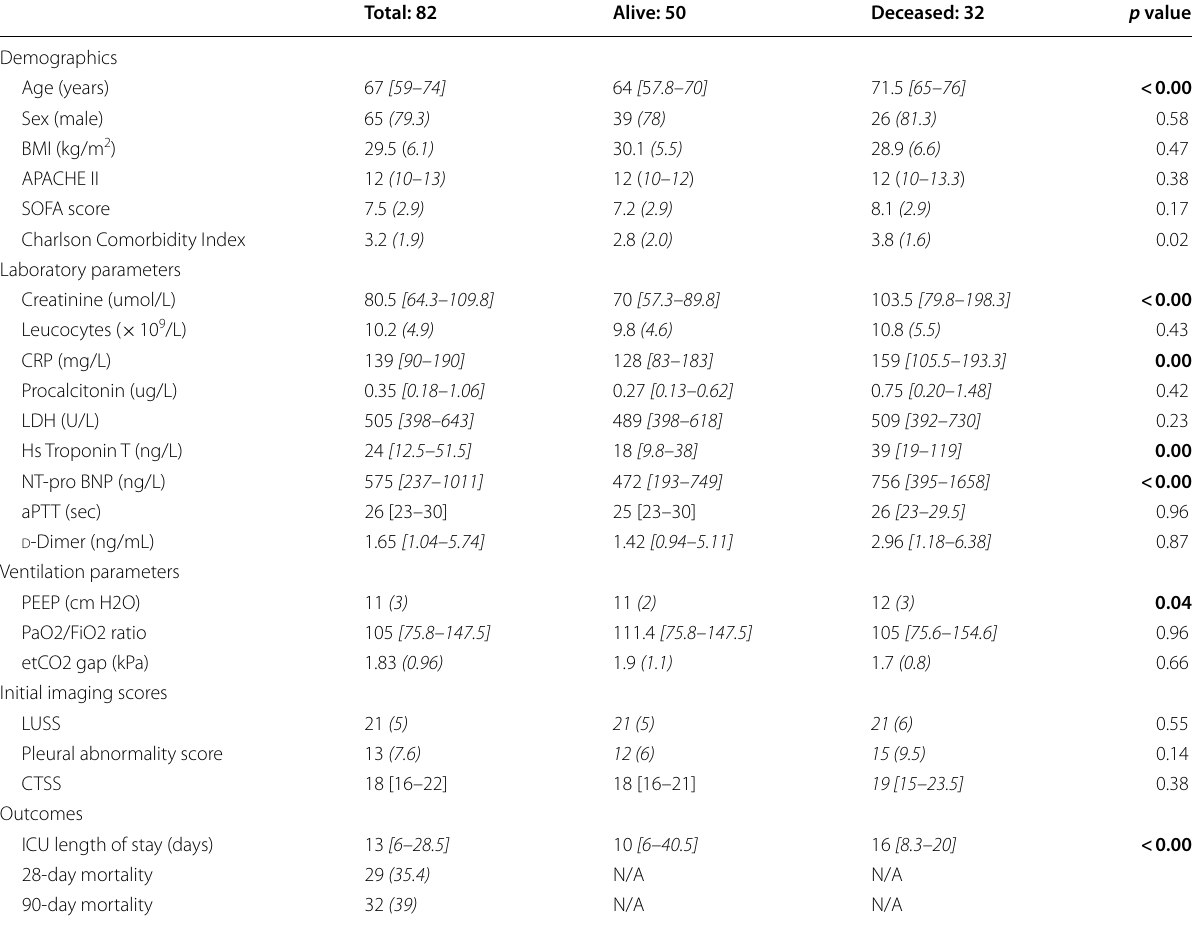
Table 1 Patient